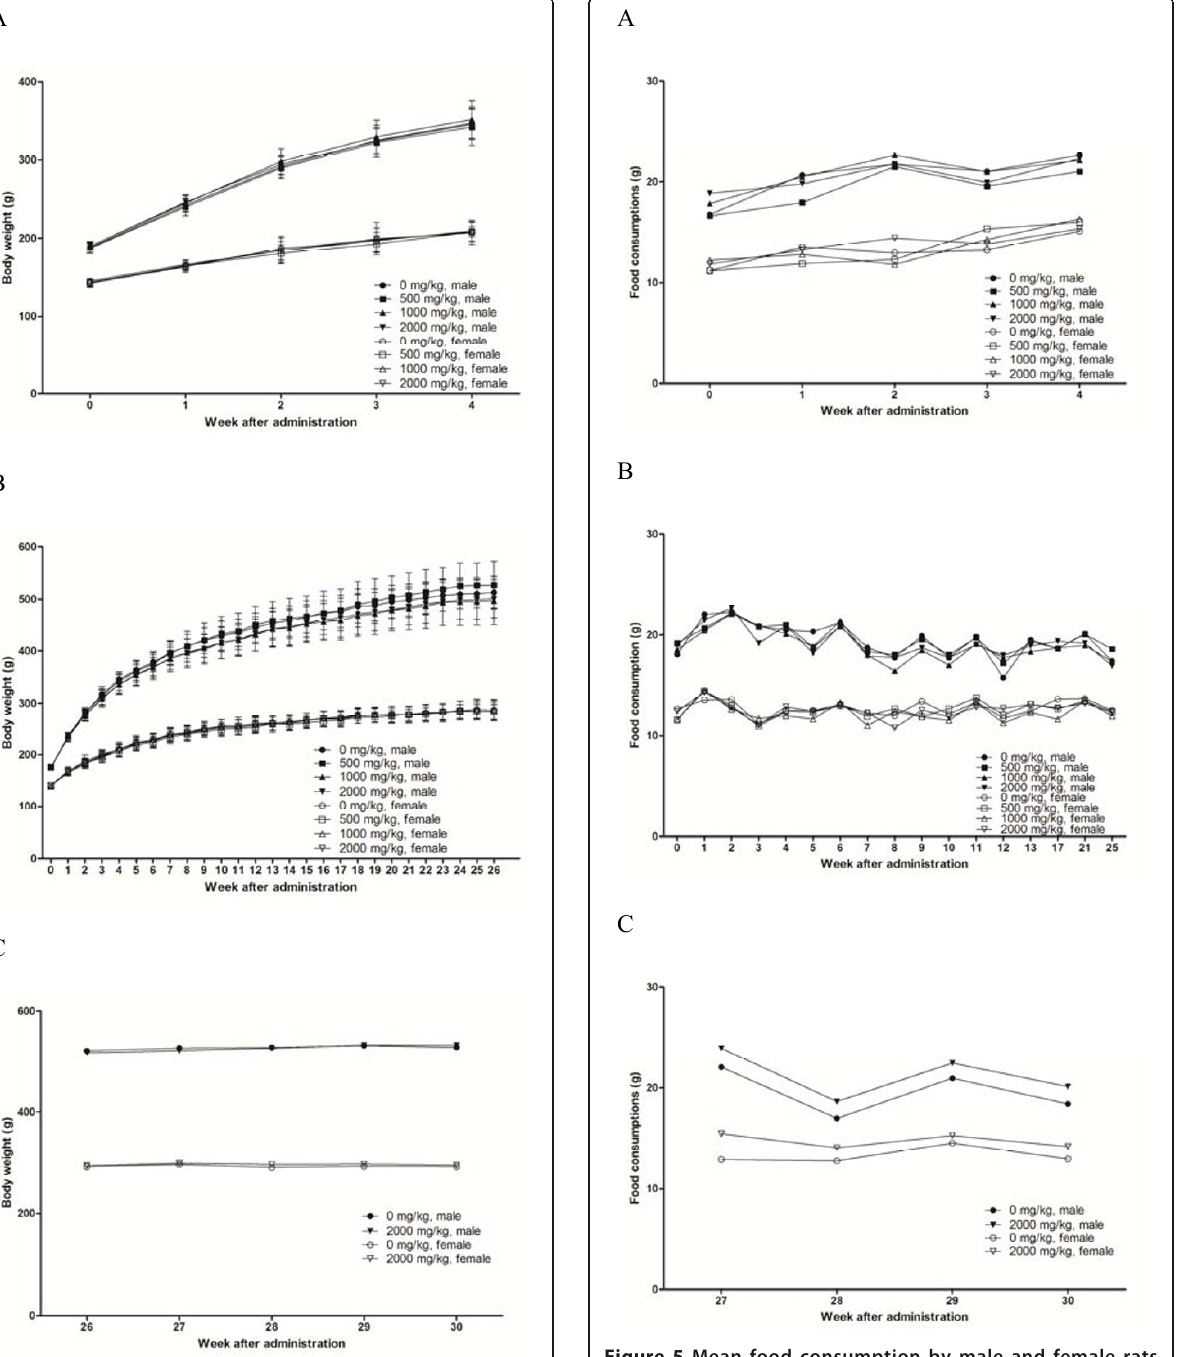
Figure 5 Mean food consumption by male and female rats treated with PM012 . Each data point represents the mean food consumption of groups of ten or fifteen animals. A) main group receiving 4 weeks of treatment, B) main group receiving 26 weeks of treatment and C) 4 weeks recovery group. Statistical analysis of the data (Dunnett ’ s test) revealed no significance differences between